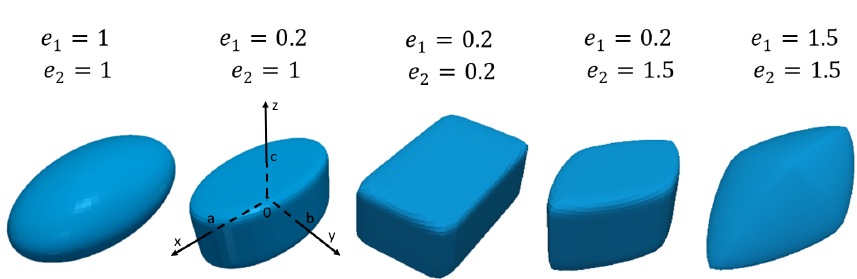
Figure 1. Examples of superellipsoids with particle frame of reference defined. From the left a triaxial ellipsoid, oval, cylinder, cuboid, rhomboid and octahedron are shown. All shapes are formed from the same axes ( a , b , c ), by only altering the exponential parameters ( e 1 , e 2